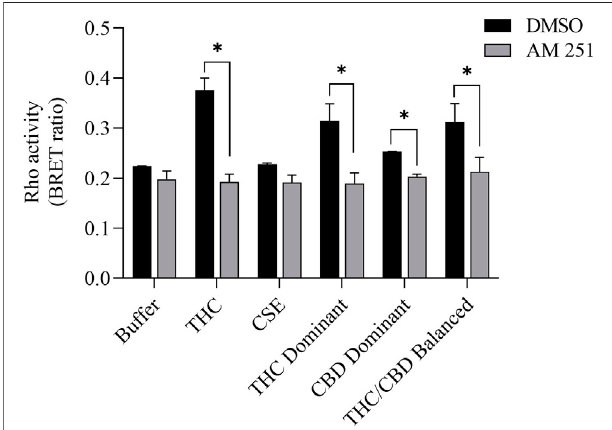
FIGURE 5 | CaSE-induced Rho activation is mediated by CB1. HEK293 cellsexpressingCB1andRhosensorwerestimulatedwith Δ 9 -THC(25 µM)or indicated CaSE (12.5%) in the absence (0.1% DMSO, black bar) or presence ofAM251(10 µM)(greybar).AM251abolishedthe Δ 9 -THC-andCaSE- mediated Rho activation in CaSE prepared from THC dominant and THC/ CBD balanced strains (* p < 0.05). CSE treatment did not increase Rho activity compared to buffer; AM 251 had no effect. Data represent mean ± SD from two independent